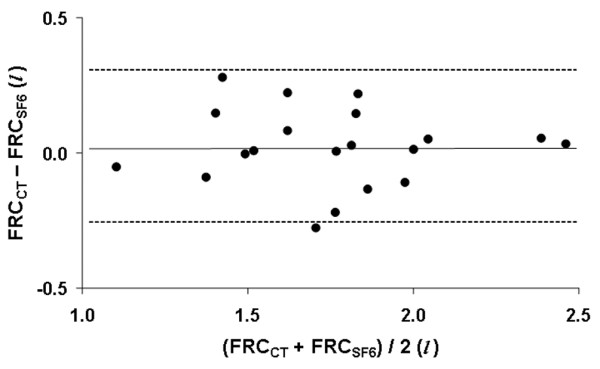
Bland-Altman plot [24] of supine functional residual capacity measured by rebreathing of sulphur hexafluoride (FRCSF6) and by computed tomography (FRCCT) in 20 healthy subjects. The individual differences of paired measurements (y axis) did not depend on the magnitude of their average values (x axis). The mean difference (solid line; dotted lines represent the mean ± 2SD) was small.